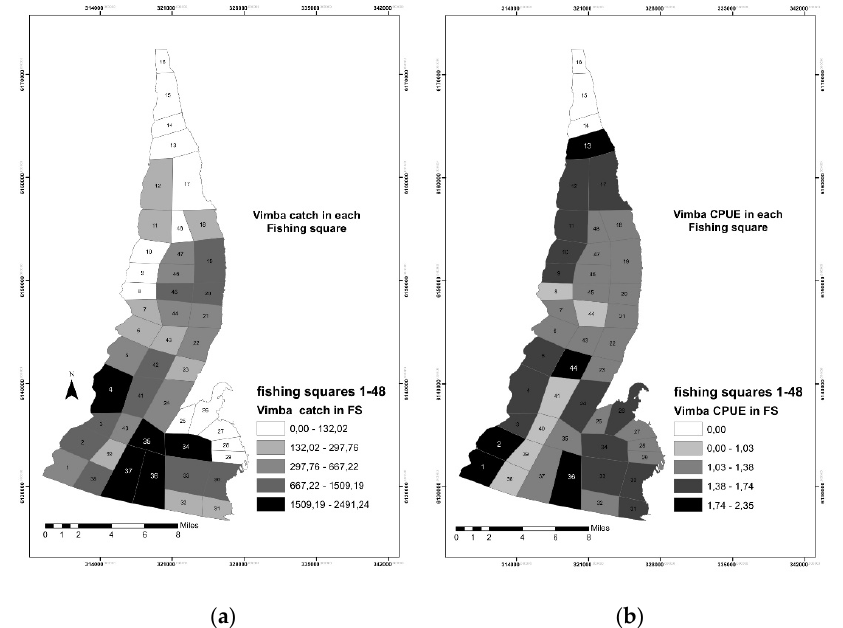
Figure 6. Distribution of vimba catches of commercial fisheries in fishing square: ( a ) total catch in each fishing square in kilograms, ( b ) CPUE of vimba by the 40–59 mm mesh size gillnets.